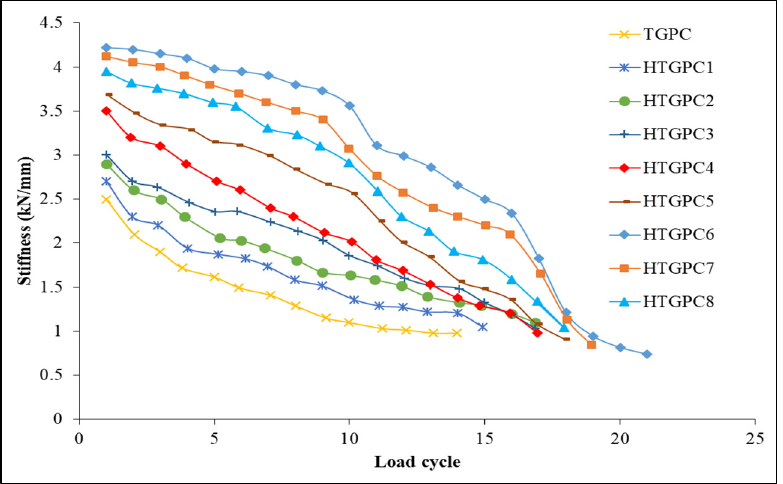
Figure 10. Stiffness degradation plots.